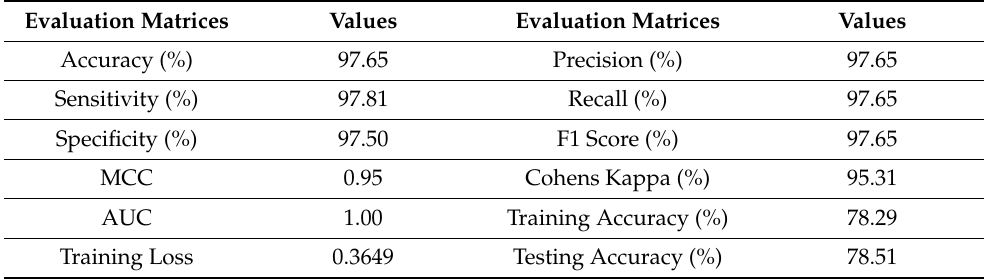
Table 1. Results of Proposed Ensemble Learning Model with Self Consistency Test.